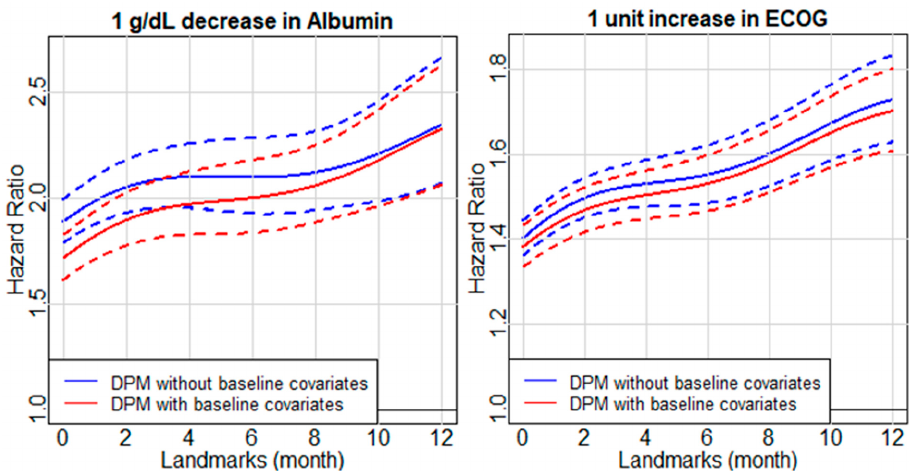
Figure 2. Dynamic hazard ratios for 1 g/dL decrease in albumin (left) and 1 unit increase in ECOG PS (right) on overall survival. Solid lines represent the dynamic hazard ratios over time and dashed lines represent the corresponding 95% confidence intervals.